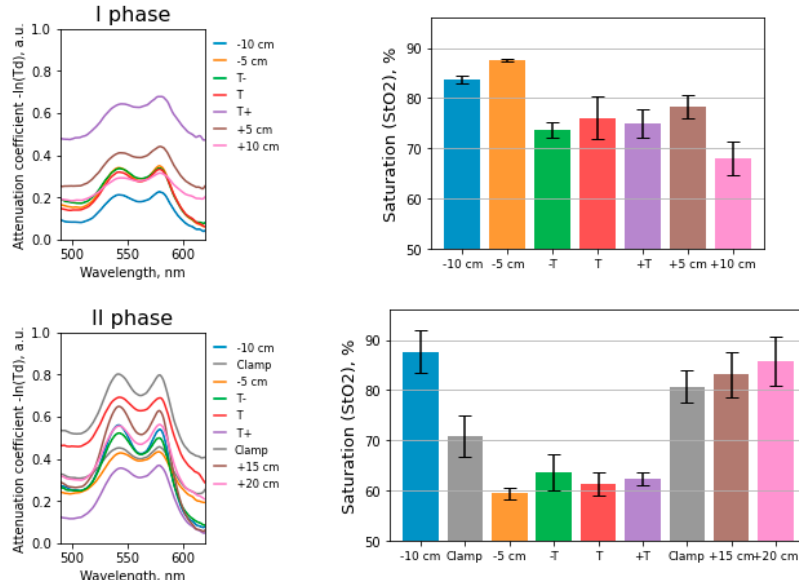
Figure 6. Absorption spectra at the points where tissue saturation was calculated. Histogram of tissue saturation values in the intestinal wall before and after mobilization.